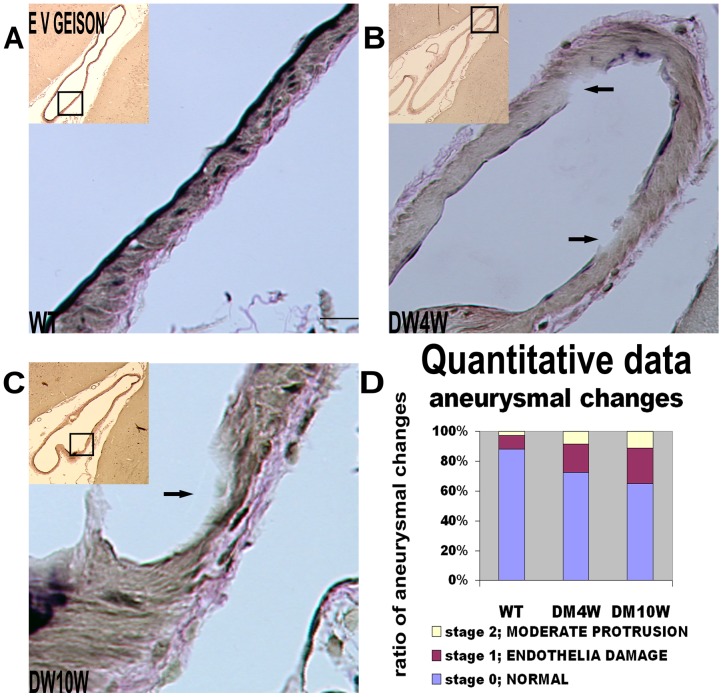
T1DM increases IA formation identified by the classification of aneurysmal changes compared with non-DM rats.
A–C: Elastica Van Geison staining: T1DM increases IA formation compared with non-DM rats. D: Quantitative data: The ratio of stage 1 and stage 2 of aneurysmal formations to total arterial number was significantly increased in T1DM rats (p<0.05). Arrows show a slight focal thinning and bulging of the arterial wall (Fig. 1B and C). Scale bar in A, 20 µm.